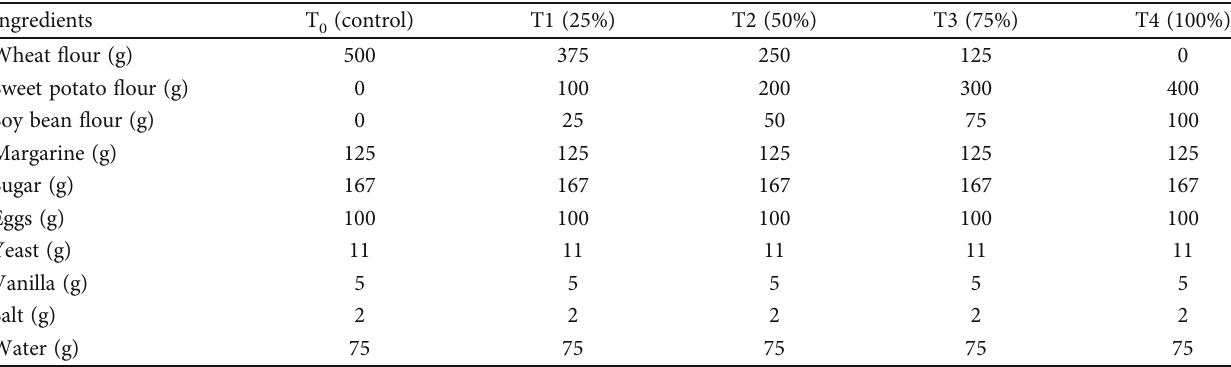
Table 1: Formulation of the